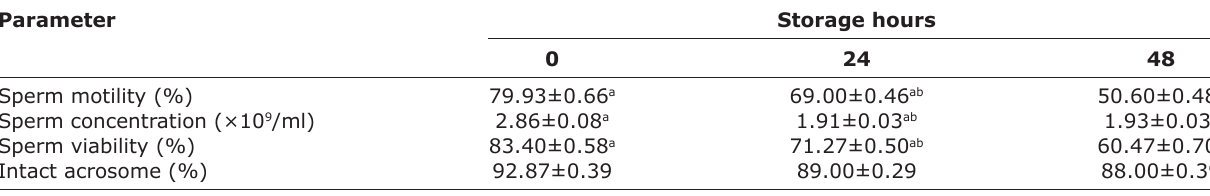
Table-2: Mean (±SEM) epididymal sperm parameters from red Sokoto bucks collected post-mortem, processed without storage, stored at 4°C for 24 and 48 h.